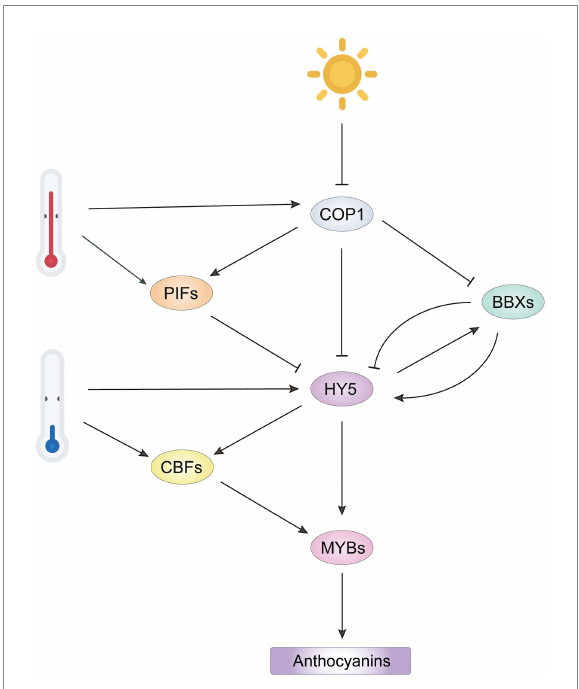
FIGURE 4 Integrated network of light-and temperature-mediated anthocyanin biosynthesis by regulation of R2R3-MYB activators. Light represses COP1 activity to release HY5 and BBX, promoting formation of an HY5-BBX module to activate downstream R2R3- MYB activators. However, BBX repressors inhibit HY5 activity by interfering the interaction of HY5 with other BBX activators. High temperature represses anthocyanin biosynthesis by stabilizing COP1 and PIFs to inactivate HY5. Low temperature induces HY5 and CBF expression, which promotes transcription of R2R3-MYB activators. The COP1/PIFs-HY5/BBXs-MYB cascade integrates the regulation of R2R3-MYB activators from light and temperature signals to regulate anthocyanin